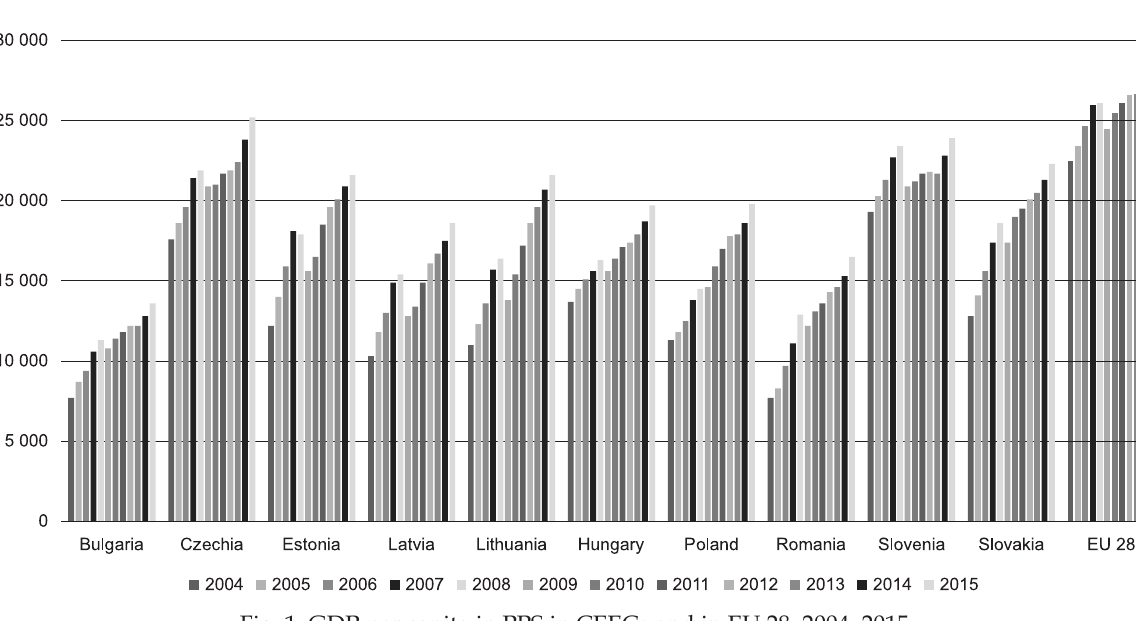
Fig. 1. GDP per capita in PPS in CEECs and in EU 28, 2004–2015. Source: own calculations based on Eurostat (2017).